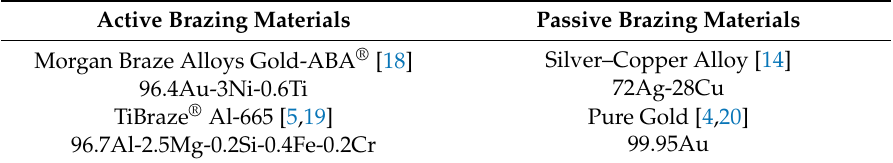
Table 1. Brazing materials selected for evaluation with lithium niobate.